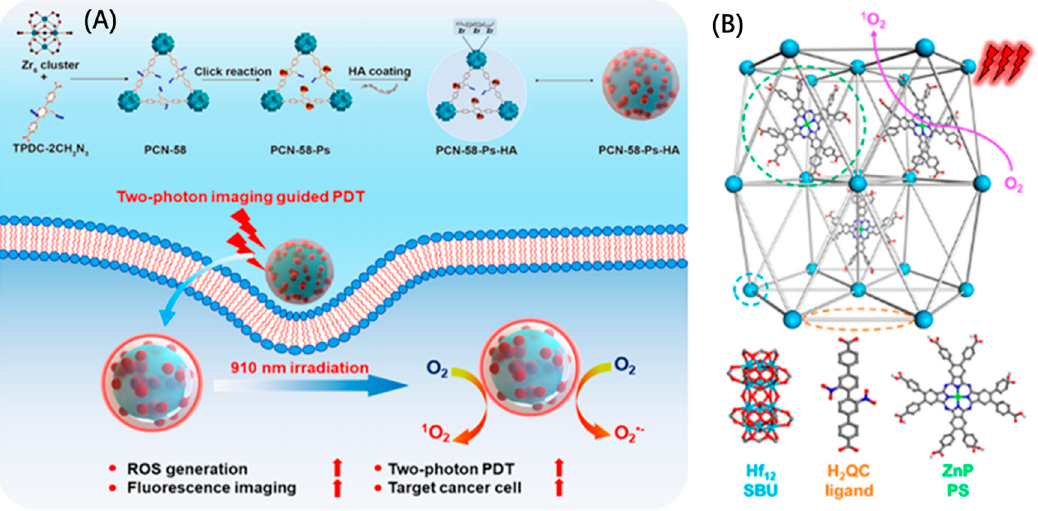
Figure 6. ( A ) Preparation of PCN-58-Ps-HA and highlighting of photo-induced ROS generation and two-photon fl uorescence imaging-guided PDT. ( B ) Structural composition of ZnP@Hf-QC : a 3D framework of Hf 12 SBUs and QC bridging ligands and ZnP PSs con fi ned in the pore space. ZnP@Hf-QC e ffi ciently produced 1 O 2 under light irradiation at 700 nm. Reprinted with permission from [69,70] . Copyright 2021 American Chemical Society.